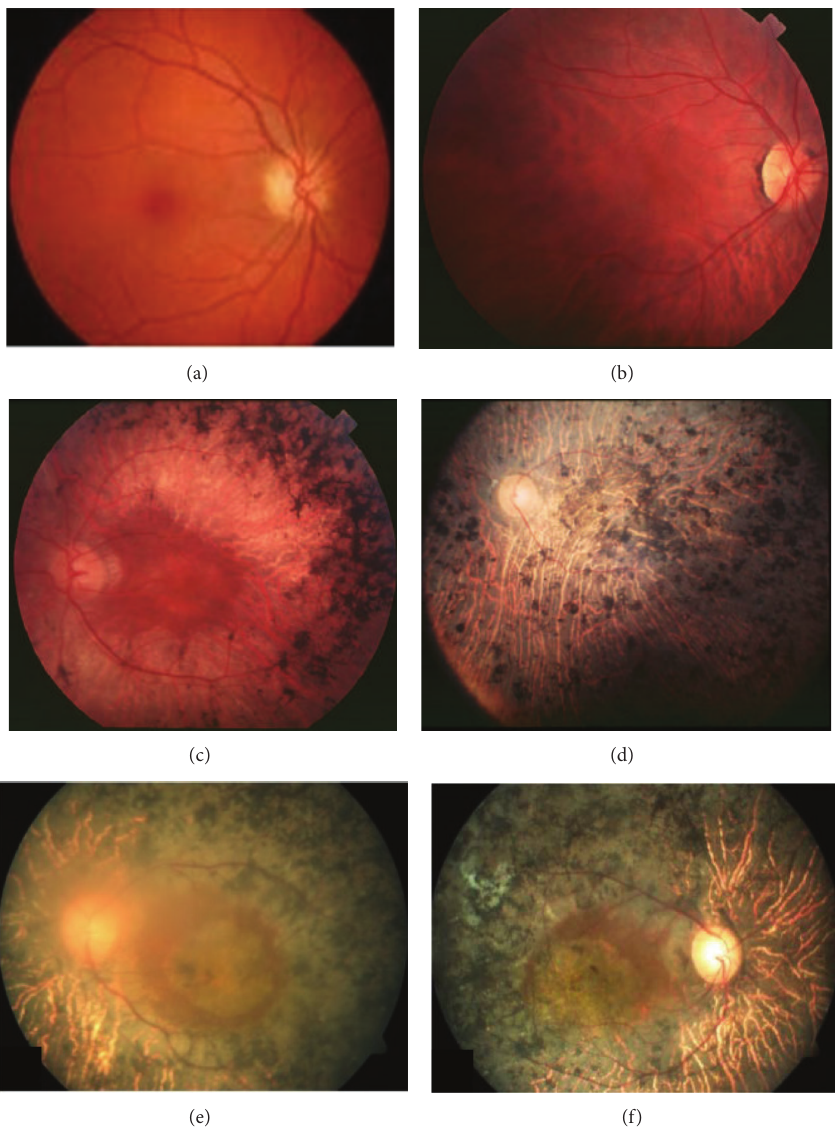
Figure 2: Fundus of an RP patient at different stages. (a) Image of a normal healthy eye. (b) Fundus of an RP patient at early stage. (c) Midstage of the disease showing midperipheral pigment deposits. (d) End-stage fundus showing pigment deposit present all over retina with thin retinal vessels and pale optic disc, modified from Hamel [23]. (e-f) End-stage fundus of an RP patient with an RPGR mutation c.852c > G (p.S284X), modified from Yang et al., 2014